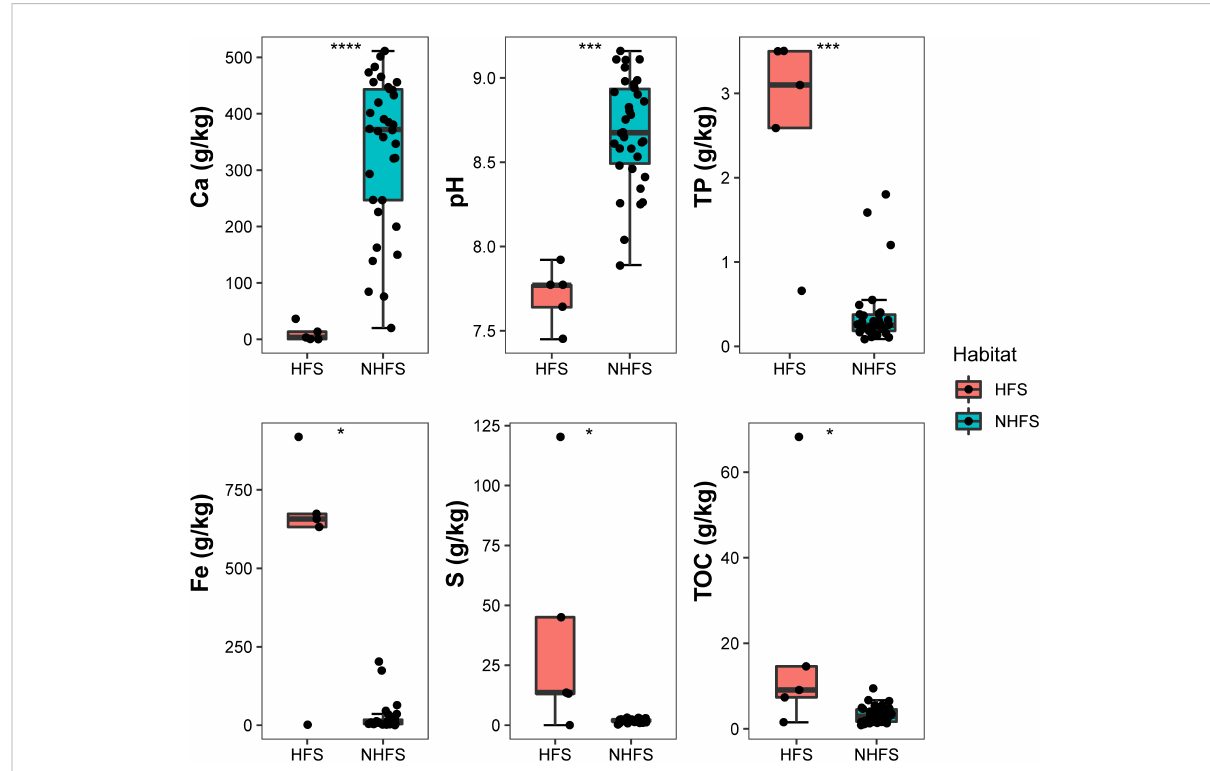
FIGURE 2 Environmental factors that are signi fi cantly different between the HFS and NHFS samples. Wilcoxon test, *, P < 0.05; ***, P < 0.001; ****, P <